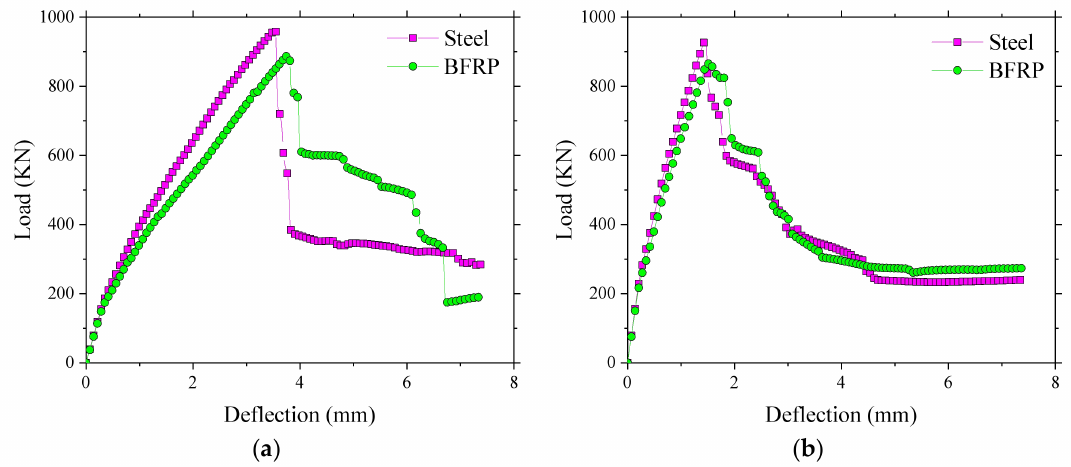
Figure 20. Load–deflection response in deck slabs by finite element (FE) analysis. ( a ) Load–deflection curve between the W-beams in the finite element model; ( b ) Load–deflection curve between W-beams and W-beams in the finite element